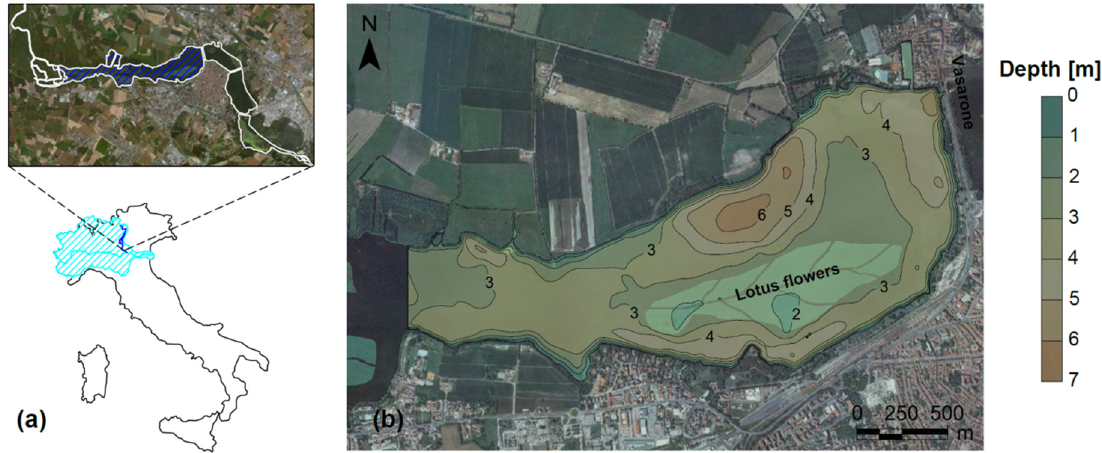
Figure 1. ( a ) Geographic position of the Mantua Lakes system; ( b ) Bathymetry of the Superior Lake of Mantua (ortophotos courtesy of Lombardy